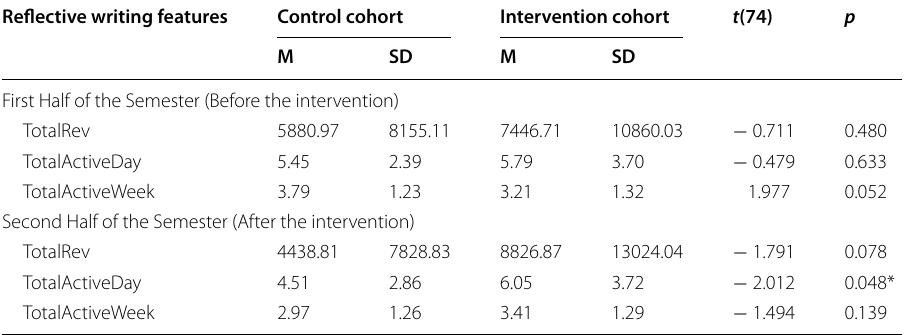
* p is significant at the 0.05 level (2-tailed)